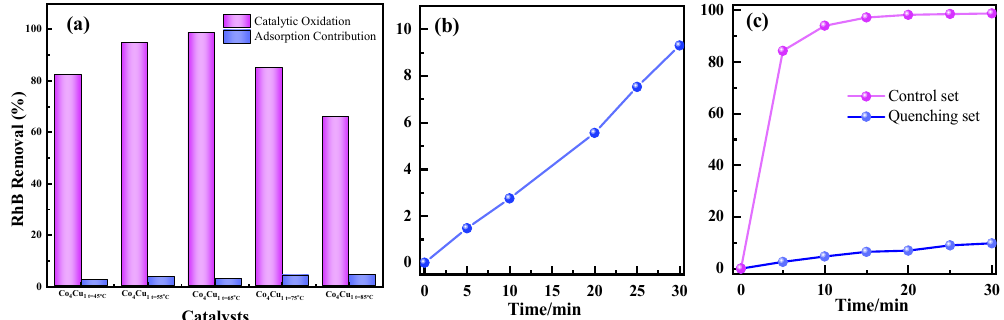
Figure 6. ( a ) Catalytic performance of catalysts; ( b ) homogeneous RhB degradation for Co–Cu t = 65 °C with C Cu2+ = 0.072 ppm and C Co2+ = 2.814 ppm according to metal leaching analysis; ( c ) quenching test for Co–Cu t = 65 °C . Table 3. Comparison of RhB removal among different catalysts. Catalysts Conditons Removal